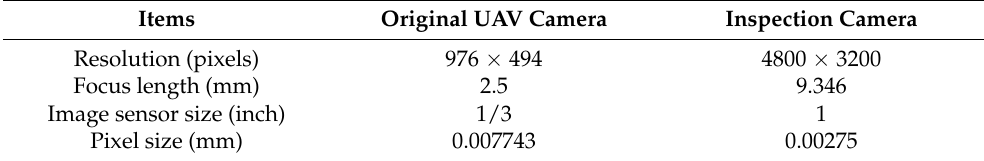
Figure 5. Architecture of the camera and laser ranging modules. 2.2.1. Synchronization Mechanism for the Operation Time of the Camera and Laser Ranging Modules When using UAV photos to measure crack information, it is crucial to ensure that the photo-shooting and ranging processes are temporally synchronized. To synchronize the operation times of the camera and laser ranging modules, Raspberry Pi 4 was used as the control system, and buses such as GPIO, UART, I2C, and SPI were used as the Raspberry Pi 4 pinouts. The system employed in this study mainly used a GPIO as its pinout to re- ceive the data transmitted by the laser ranging modules through a UART. The laser rang- ing modules transmit data to a USB module through the UART, which transmits the data to Raspberry Pi 4 by connecting four transfer modules to the USB hub. When the USB hub is connected to Raspberry Pi 4, under the Raspberry Pi 4 Linux operating system, the Synchronous operation mode, which is programmed in Python and used to control the camera and laser ranging modules, will create four systematic abstract files (i.e., ttyUSB0, ttyUSB1, ttyUSB2, and ttyUSB3) stored in the dev folder of the root directory. The four files each represent the four connected rangefinders, and the baud rate of UART, which is used to communicate with the rangefinders and Raspberry Pi 4, is 19200 bits per second. Raspberry Pi 4 controls the camera by using the camera release cable as the command transmission cable to take pictures. The downstream end of the camera release cable uses the micro-USB, which includes a shutter (red wire), a focus (white wire), and two ground (yellow wires). First, the yellow wire was connected to the ground of the Raspberry Pi 4. Next, the white and red wires were connected to the GPIO pin of the Raspberry Pi 4. Then, a low potential was output through the GPIO of the Rasp- berry Pi 4 to control the camera and take pictures. The operation process of the system is as follows: Raspberry Pi 4 automatically exe- cutes the system program when it is turned on. Subsequently, the rangefinders and cam- era are turned on. The UAV remote control is used to connect to the electronic switches through the radio to drive Raspberry Pi 4, then simultaneously captures photos and makes ranging measurements. Once the UAV remote control transmits a command, Raspberry Pi 4 will execute an action, so that the writing frequency can be adjusted according to requirements during bridge inspection. When the image is received, the ranging value and time are recorded in the text file (*.txt) to calculate the projection plane (Figure 6).